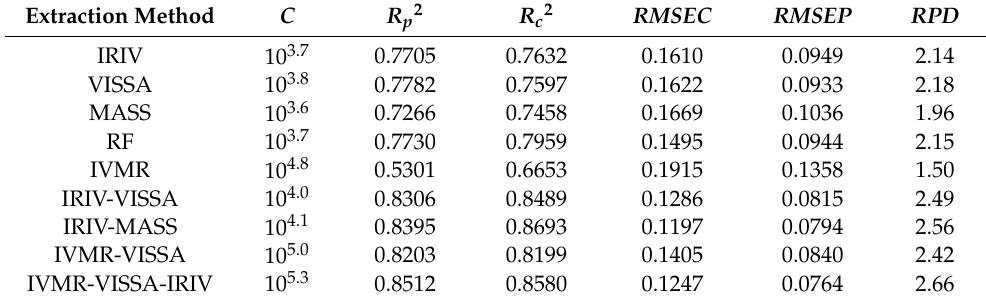
Table 8. The prediction results of MK-SVR.